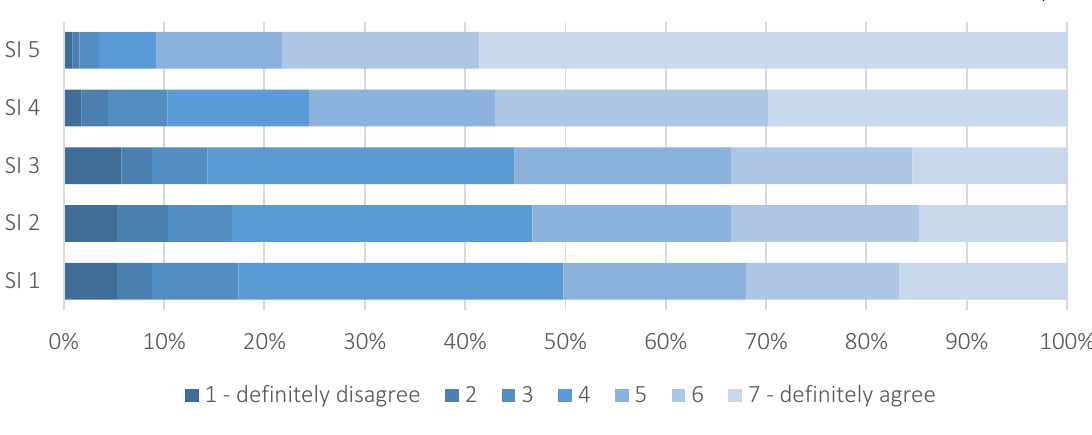
Figure 3. Overview of results for the social influence Table 3. Results for the social influence factor